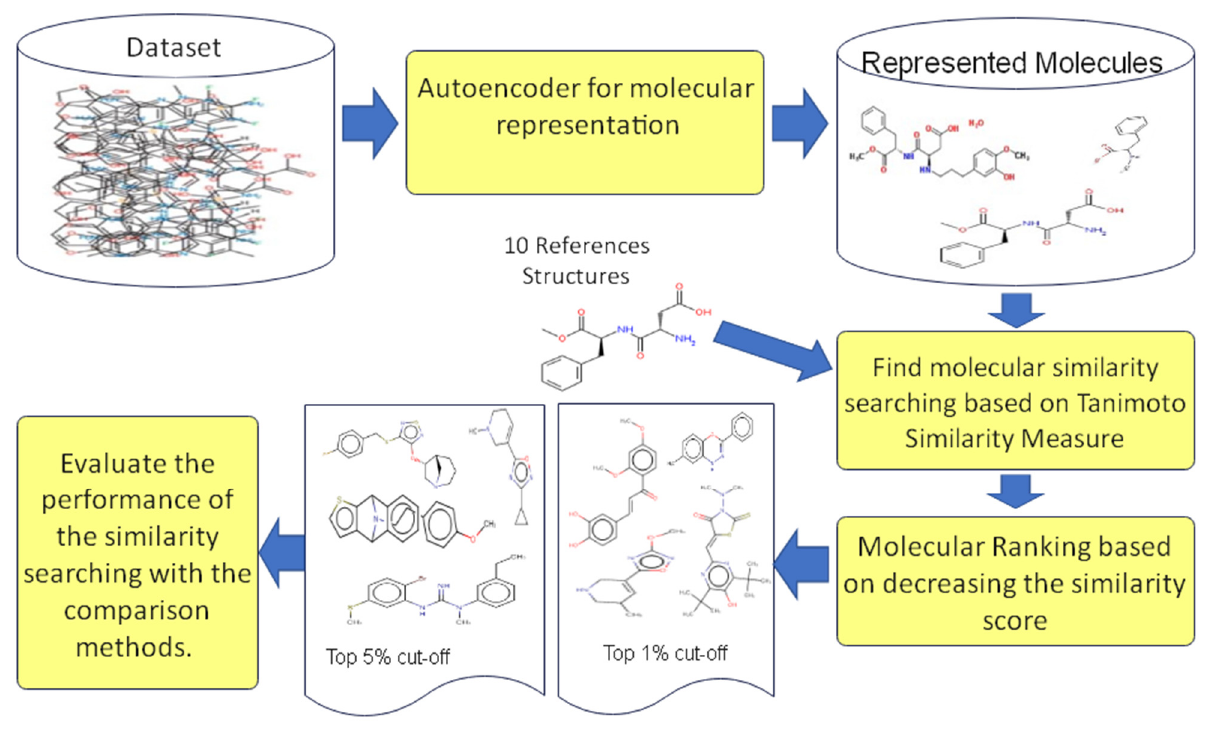
Figure 7. The Experimental design Figure 8. The Experimental design processes.